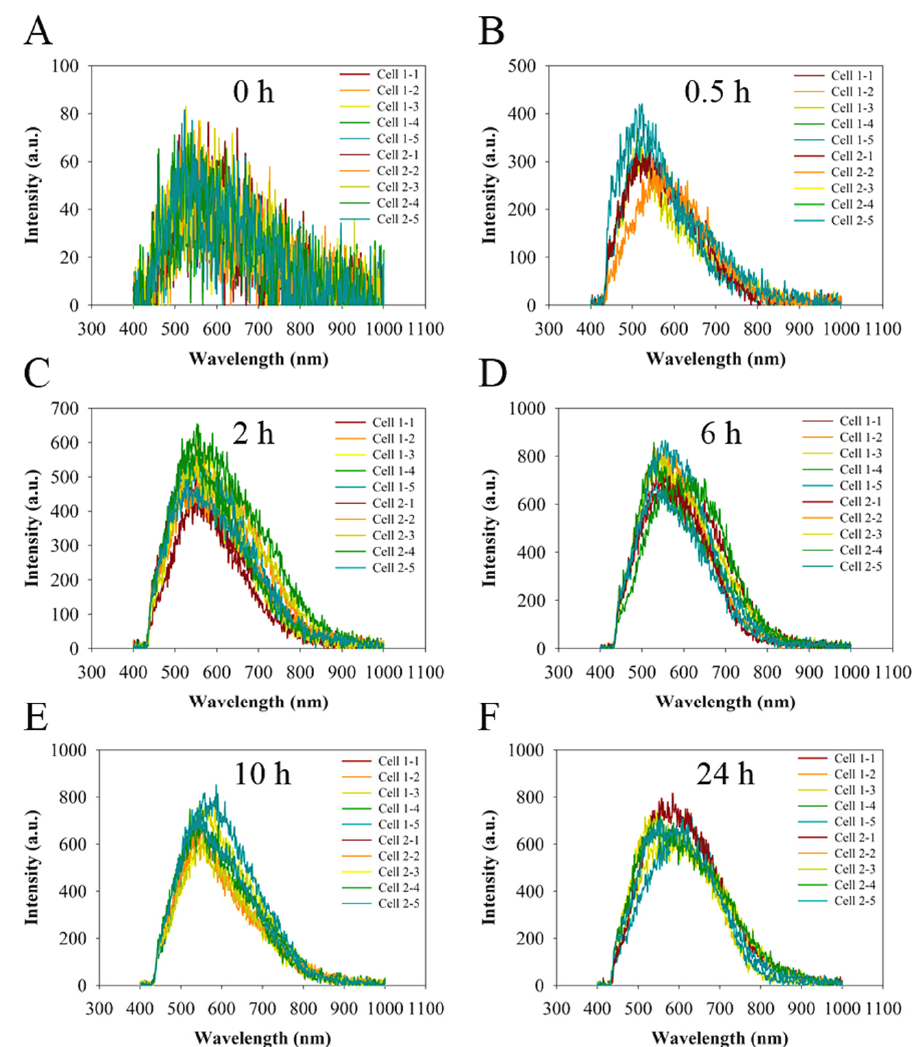
Figure 3. Light intensity spectra (a total of 34 measurements) of the nuclear area of the cells without CNDs ( A ) or with 750 µ g/mL of CNDs for different incubation times from 0.5 h to 24 h ( B – F ).